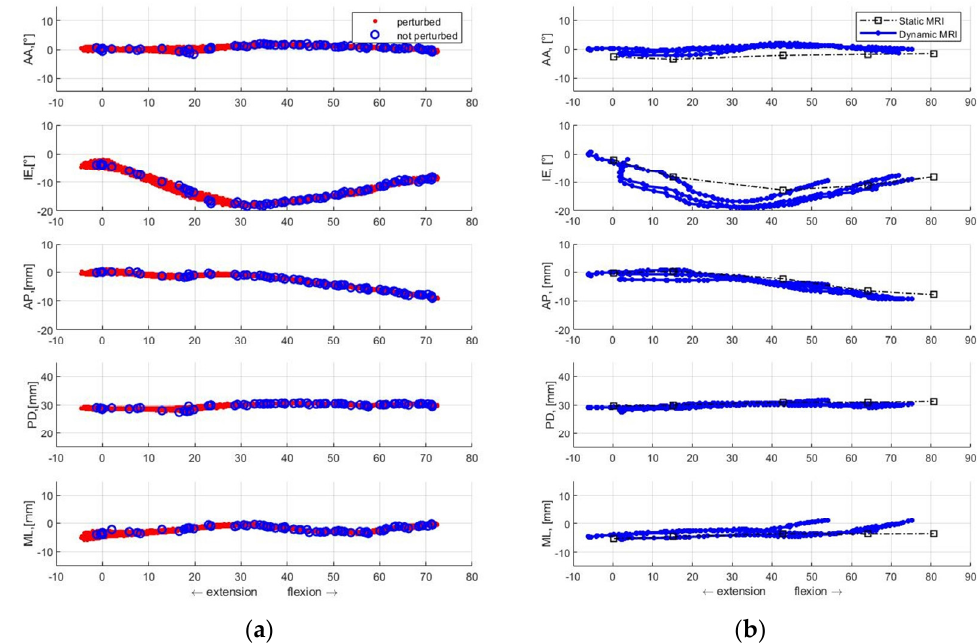
Figure 8. ( a ) Comparison between knee kinematics reconstructed from three repetition of dynamic (blue) and static (black) MRI for one volunteer. The Abduction/adduction (AA), internal/external rotation (IE), anterior/posterior (AP), proximal/distal (PD), and medial/lateral (ML) translations are plotted. ( b ) Comparison among the kinematics reconstructed from DMRI without (blue) and with (red) perturbations. In red, the 1421 cases (97.6%) not affected by perturbation of the initial pose are plotted.